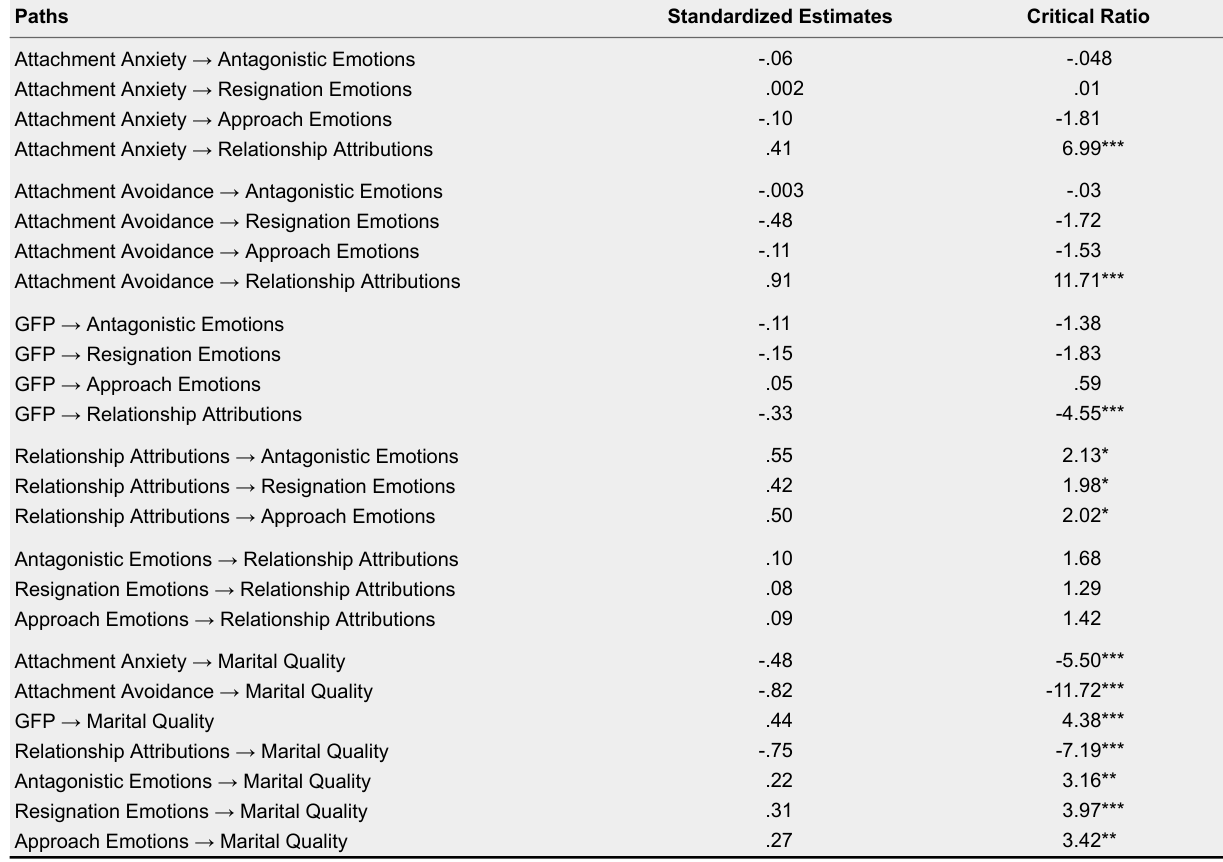
Standardized Estimates of Relationships Between Attachment Anxiety and Avoidance, GFP, Relationship Attributions, Emotional Reactions, and Marital Quality